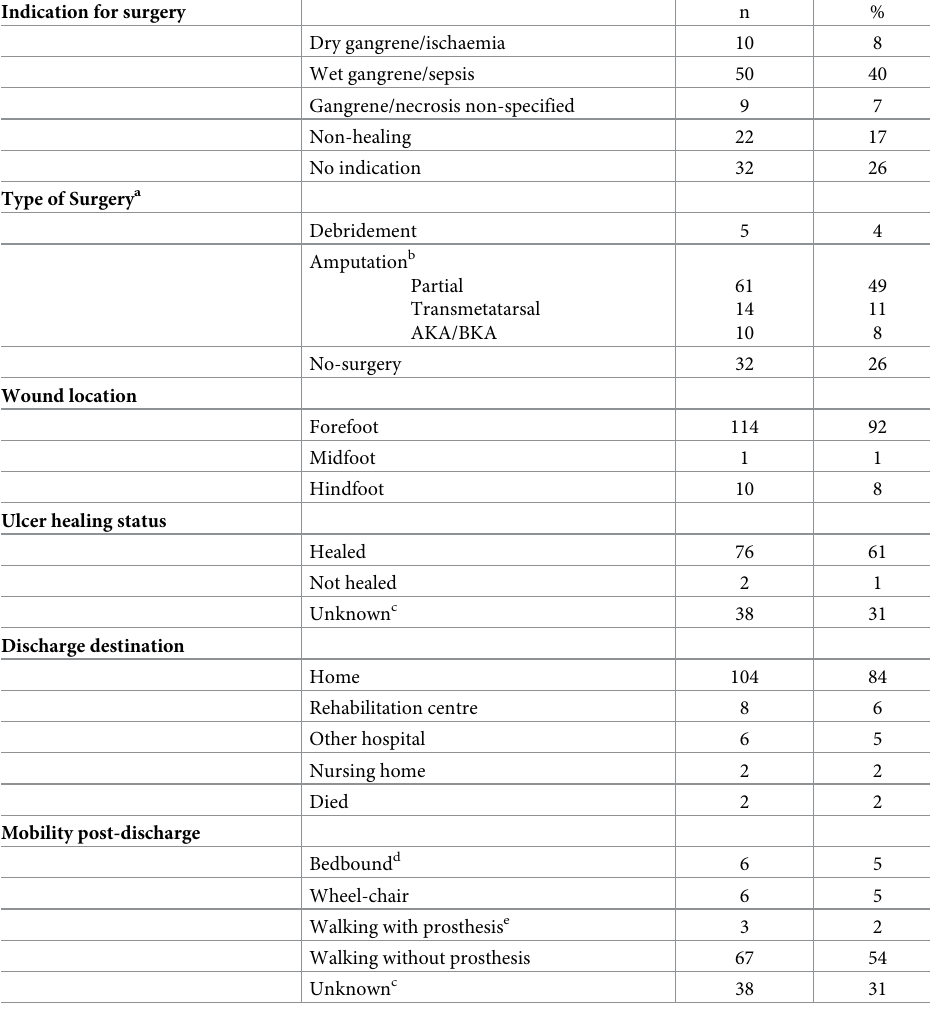
Table 7. Surgery and post-surgery outcome of patients with diabetic foot osteomyelitis. Indication for